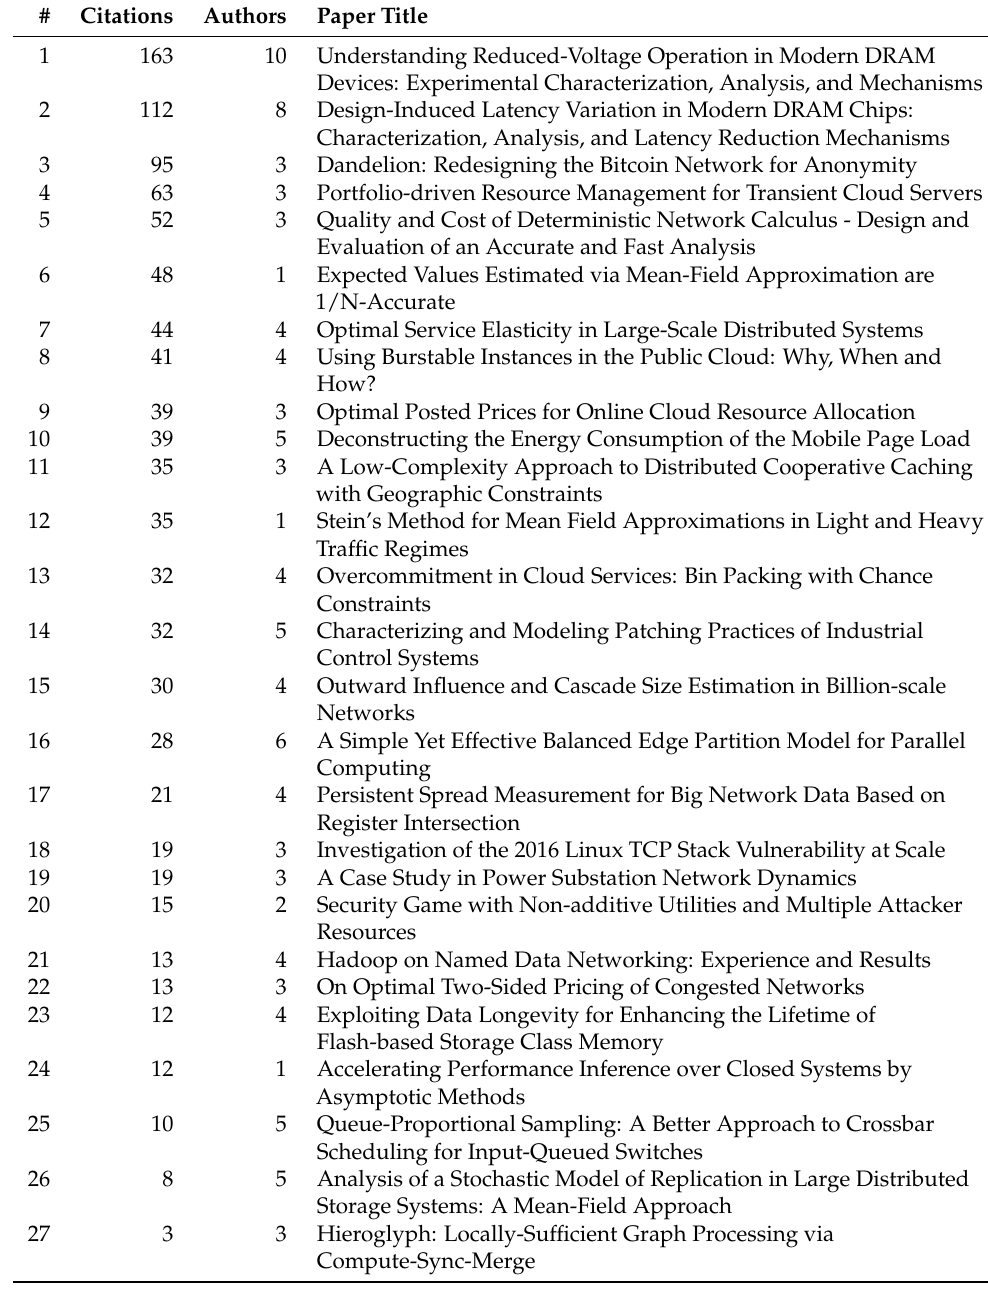
Table 1. All SIGMETRICS’17 research papers, ordered by citations after exactly five